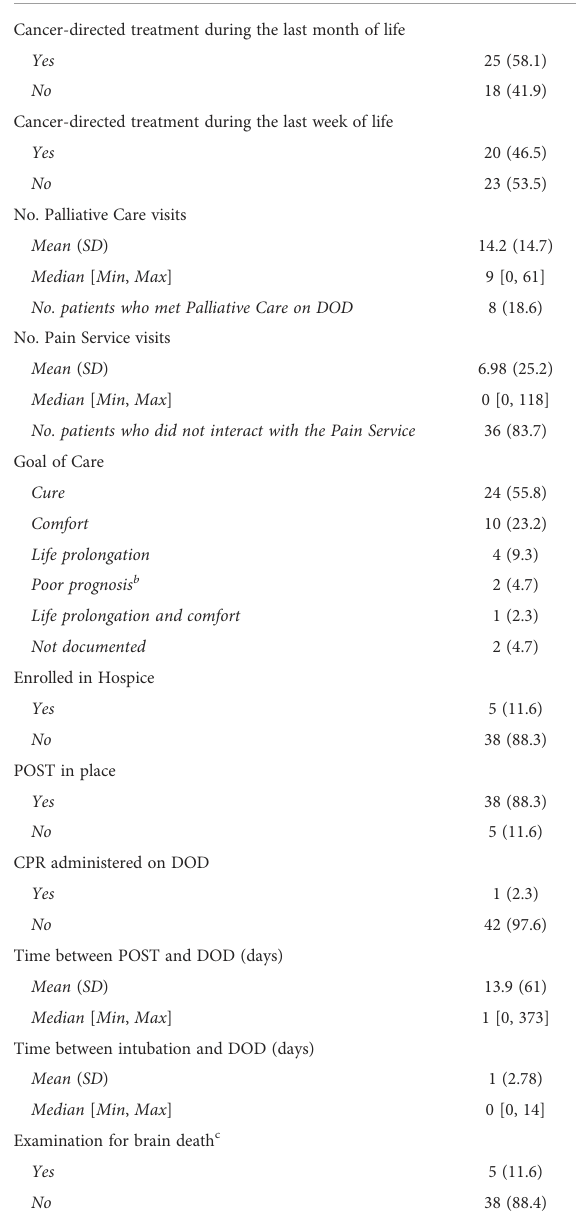
TABLE 3 End-of-life characteristics of 43 pediatric patients undergoing compassionate de-escalation of life-sustaining treatments.